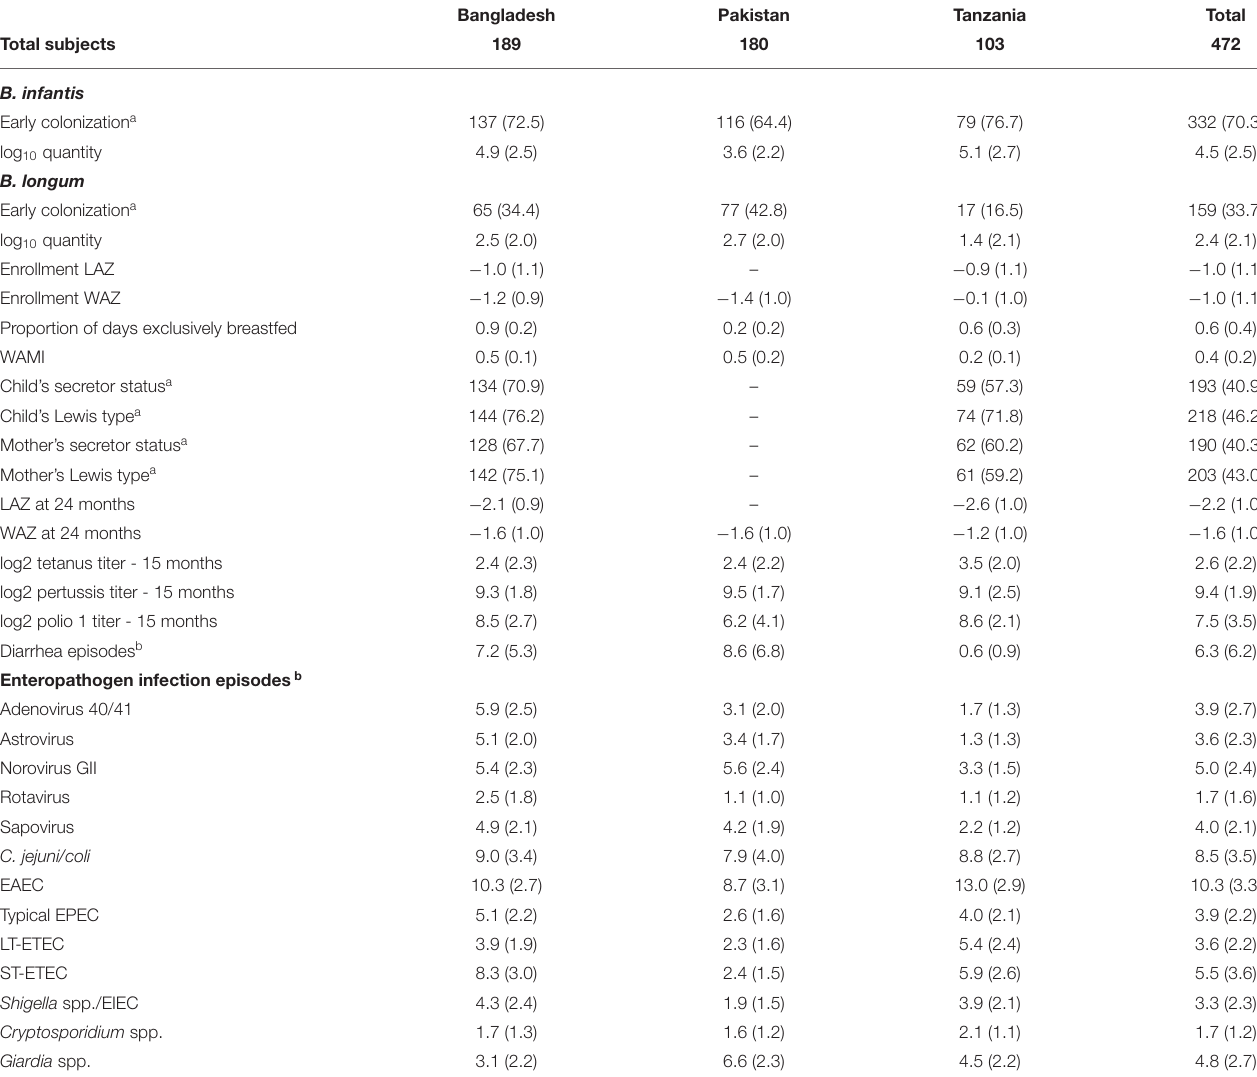
TABLE 1 | Summary statistics for variables included in the analysis by study site and overall.